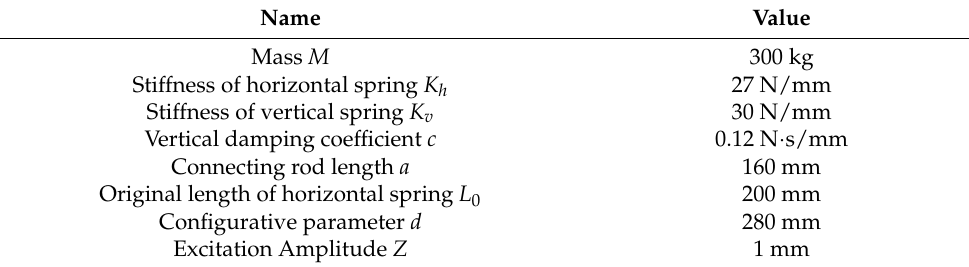
Table 1. Simulation